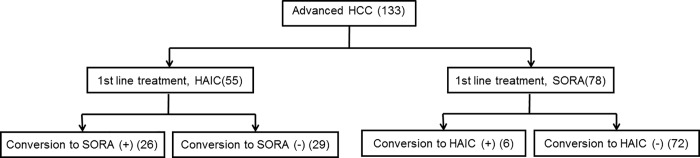
Study chart showing the number of subjects per group.HAIC; hepatic arterial infusion chemotherapy, HCC; hepatocellular carcinoma, SORA; sorafenib.